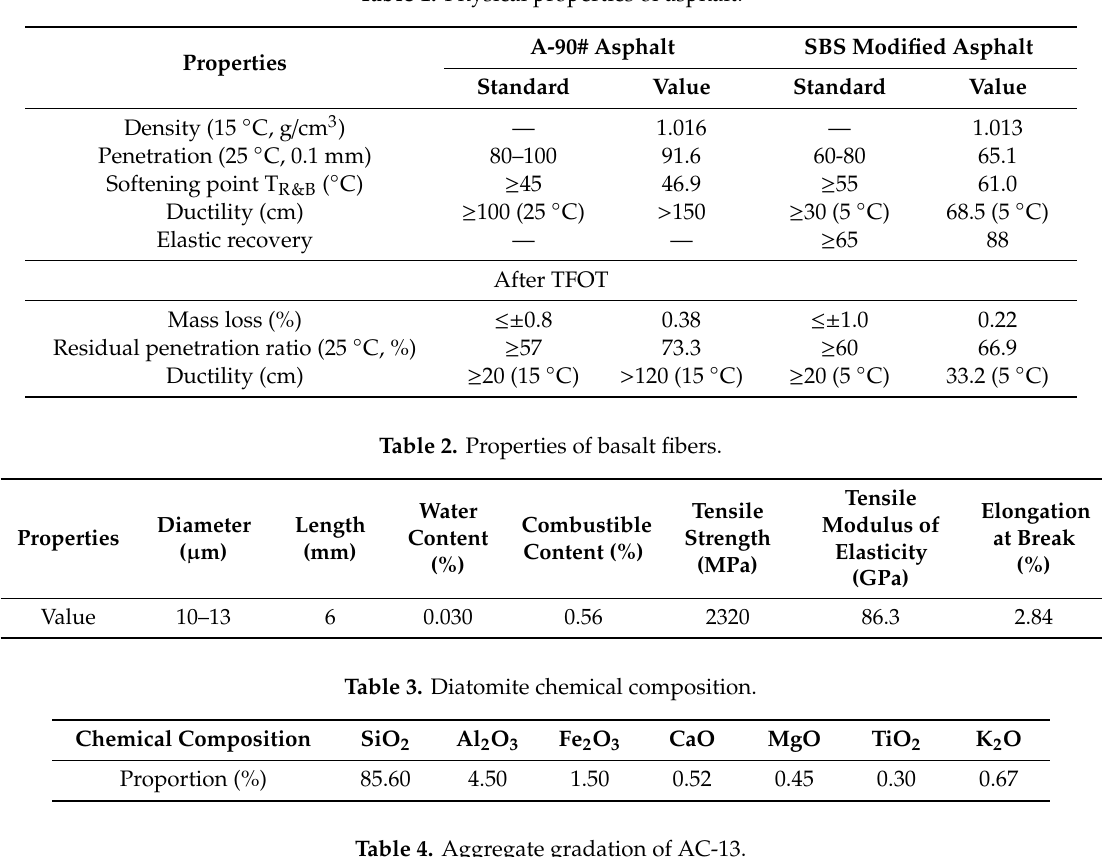
Table 1. Physical properties of asphalt.